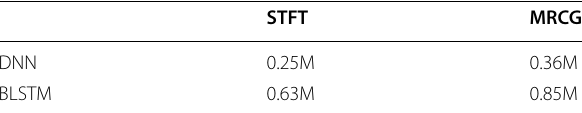
Table 1 Computational resources (in terms of number of parameters) required by the proposed approach and the baselines